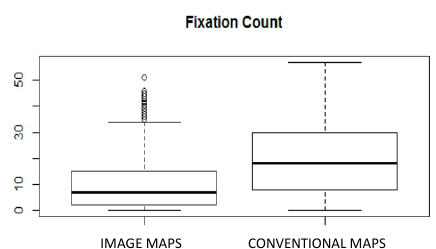
Figure 6. Fixation count boxplot – image maps (left) and conventional maps (right).